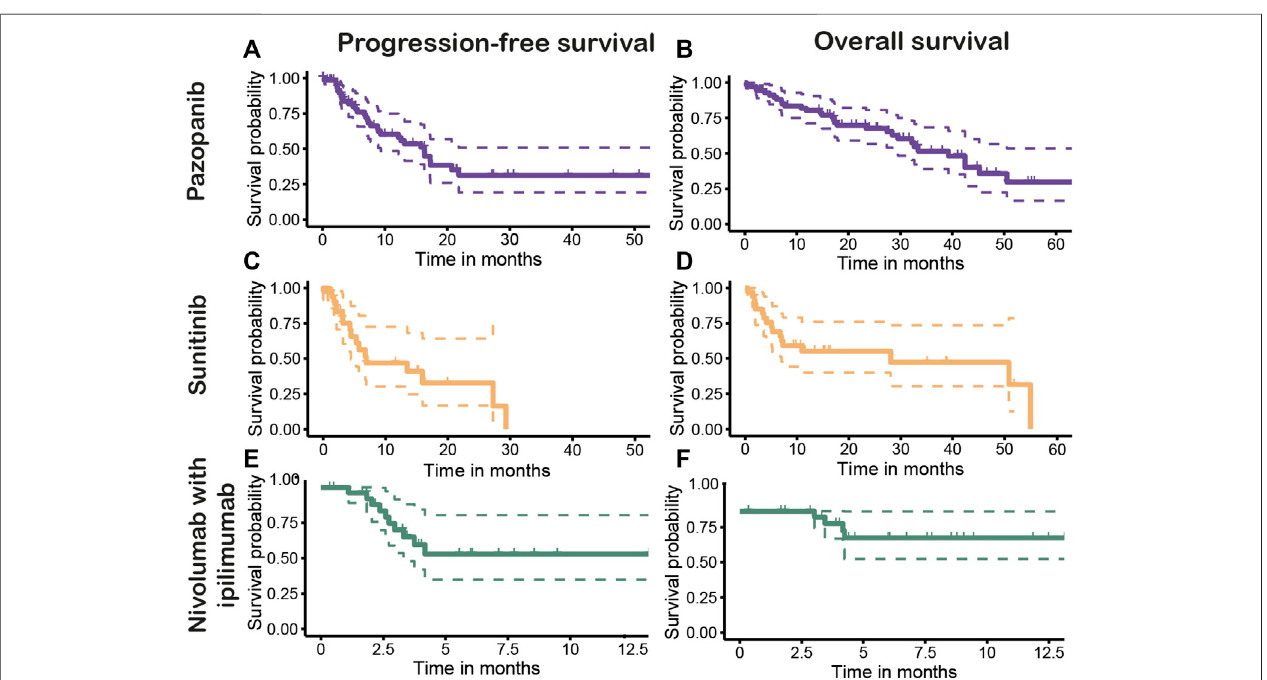
FIGURE 4 | Progression-free (PFS) and overall survival (OS) of fi rst-line treatments pazopanib [ (A) : PFS, (B) : OS], sunitinib [ (C) : PFS, (D) : OS], and nivolumab with ipilimumab [ (E) : PFS, (F) : OS].